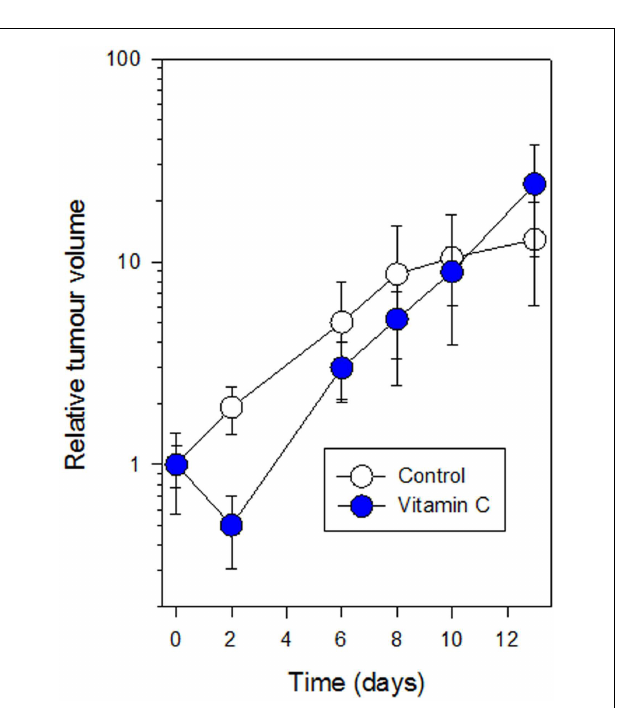
FIGURE 5 | Growth of subcutaneous Colon 38 tumors following i.p. administration of vitamin C (4g/kg) (filled circles) as compared to control mice (open circles) is shown .Vertical bars represent SEM (five mice per